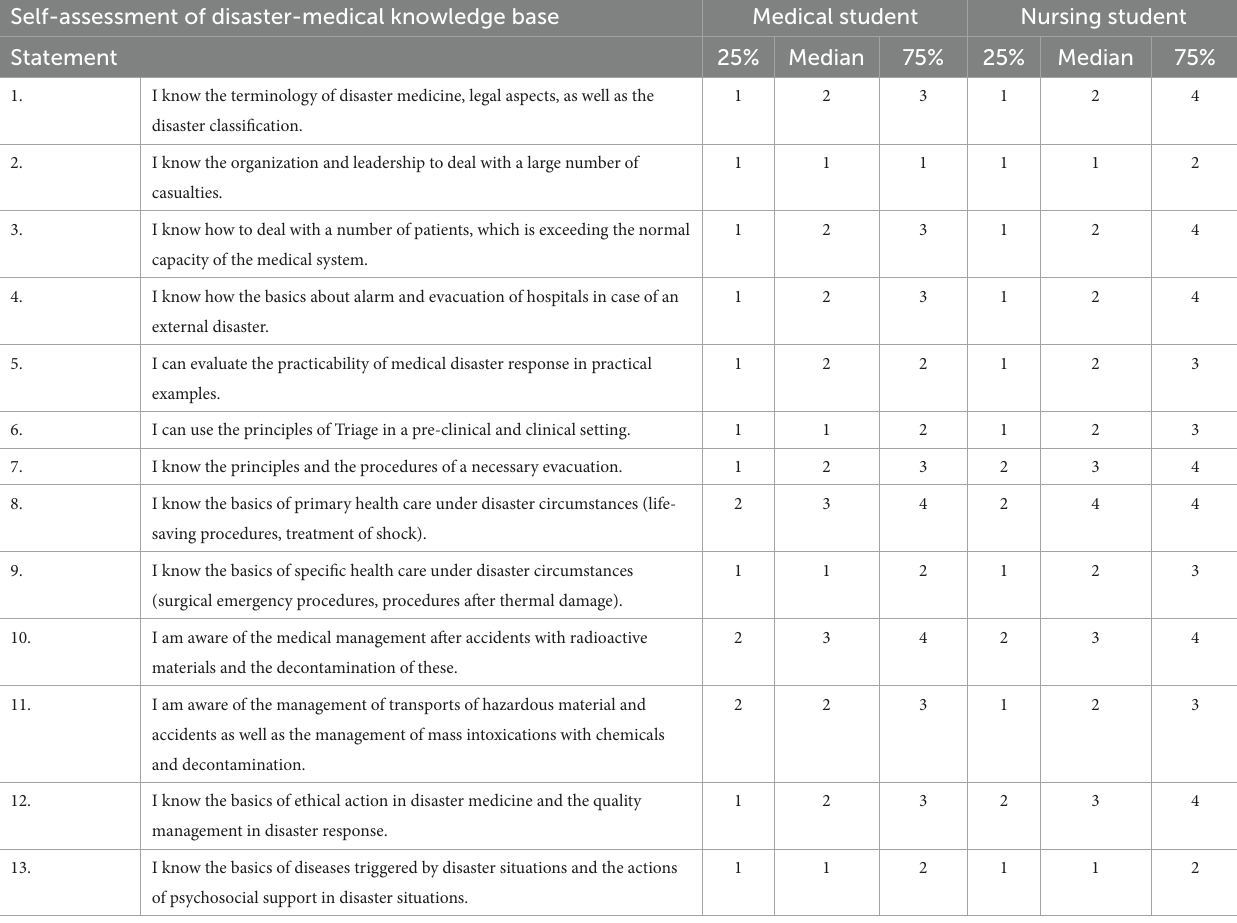
TABLE 3 Summary of self-assessment of disaster medical knowledge by senior medical (semesters 8–11) and nursing students (semesters 5 and 6) on a Likert scale [1 (“I strongly disagree”), 2 (“I disagree”), 3 (“Neutral”), 4 (“I agree”), to 5 (“I strongly agree”)], presented as median with 25 and 75% quantiles. Self-assessment of disaster-medical knowledge